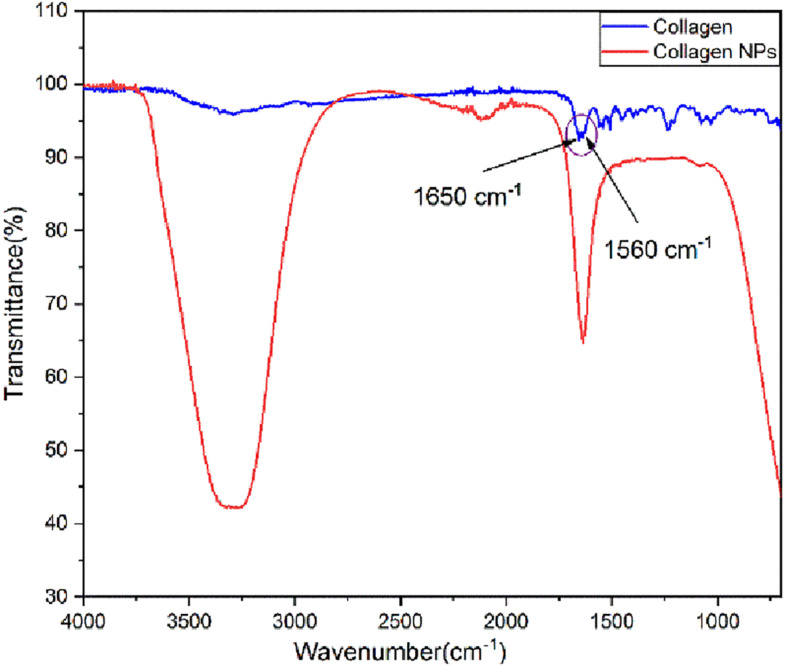
Fourier transform infrared (FT-IR) spectra of pure collagen and collagen nanoparticles.